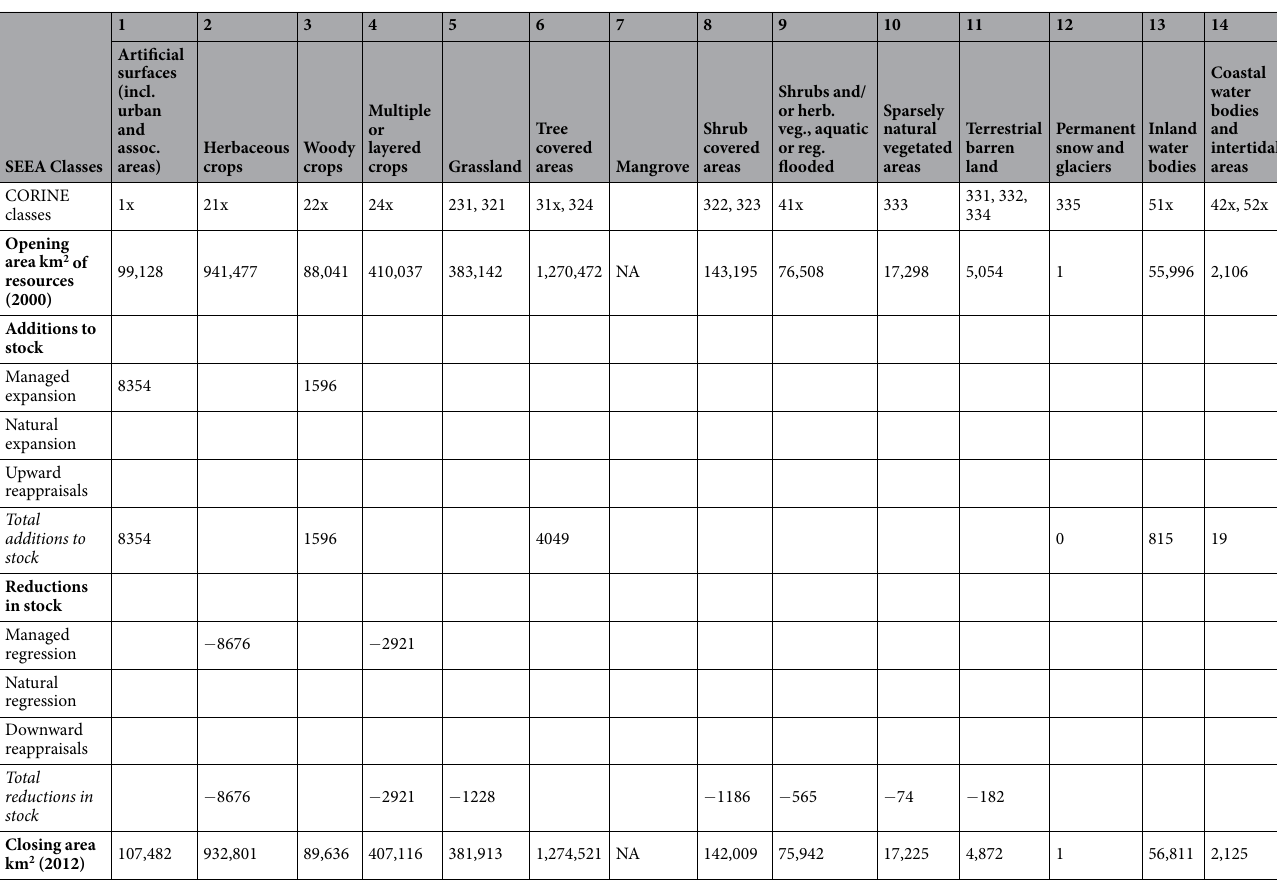
Table 1. Extent account for change in land cover assets between 2000 and 2012 for the